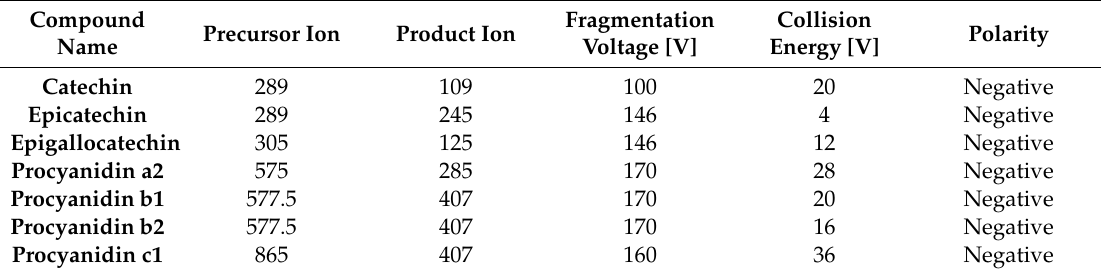
Table 3. Parameters characterizing LC / MS detection for catechin and procyanidin